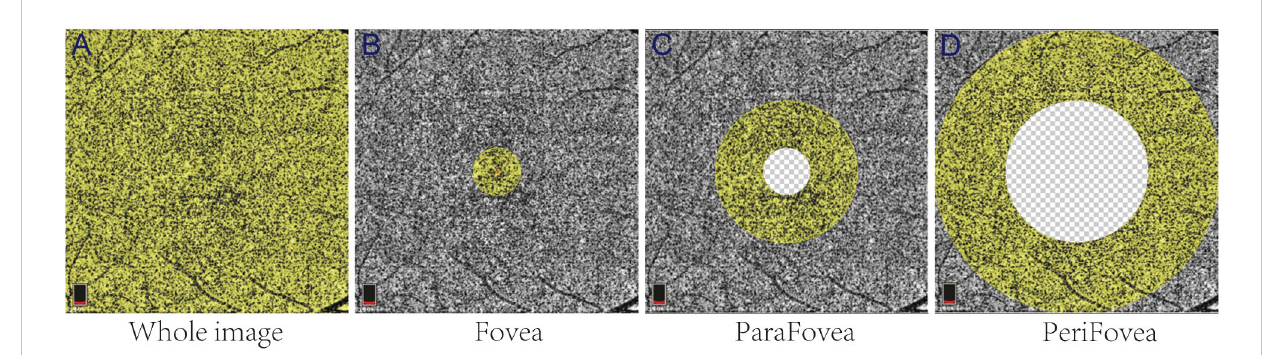
FIGURE 1 Representative partition images of the macular choriocapillaris. The yellow areas in (A – D) represent the whole-image, Fovea, ParaFovea, and PeriFovea regions,